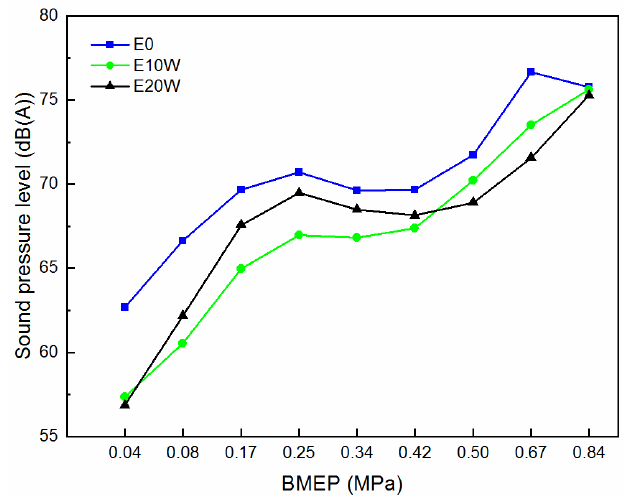
Figure 2. Noise emissions of three fuels at various loads.